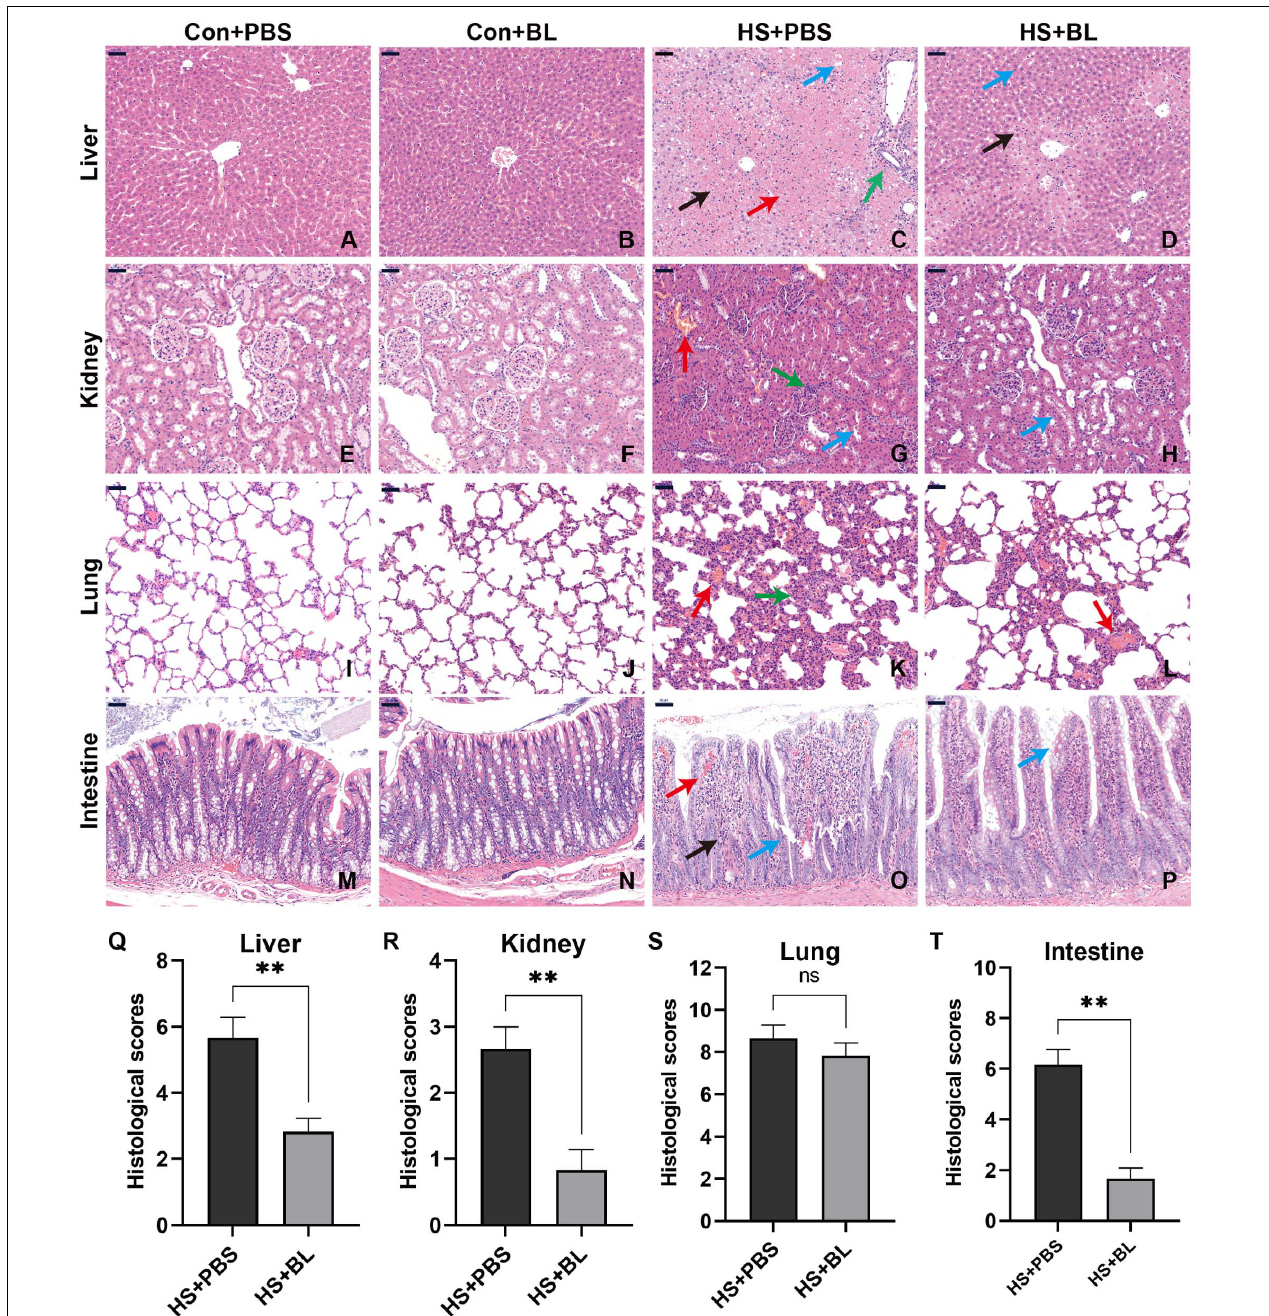
FIGURE 3 | BL pre-administration attenuated multiple-organ injury in HS rats. Organ samples were harvested at 3 h after HS and stained with H&E. Representative histopathological images are shown of liver (A–D) , kidney (E–H) , lung (I–L) , and intestine (M–P) from Con + PBS, Con + BL, HS + PBS, and HS + BL (left to right) groups, magnification 200 × . Scale bar = 50 µ m. Arrows indicate typical pathological changes including necrosis, inflammation, vacuolar degeneration, congestion, hemorrhage, and alveolar wall thickening. Histological scores of liver (Q) , kidney (R) , lung (S) , and intestine (T) were counted and plotted. Values are presented as means ± SEM; n = 6 per group. ns P > 0.05, ∗∗ P < 0.01. Black arrows indicate necrosis; green arrows, inflammation; red arrows, congestion or hemorrhage; blue arrows, organ-specific alternations, such as villi destruction or hepatocyte vacuolar